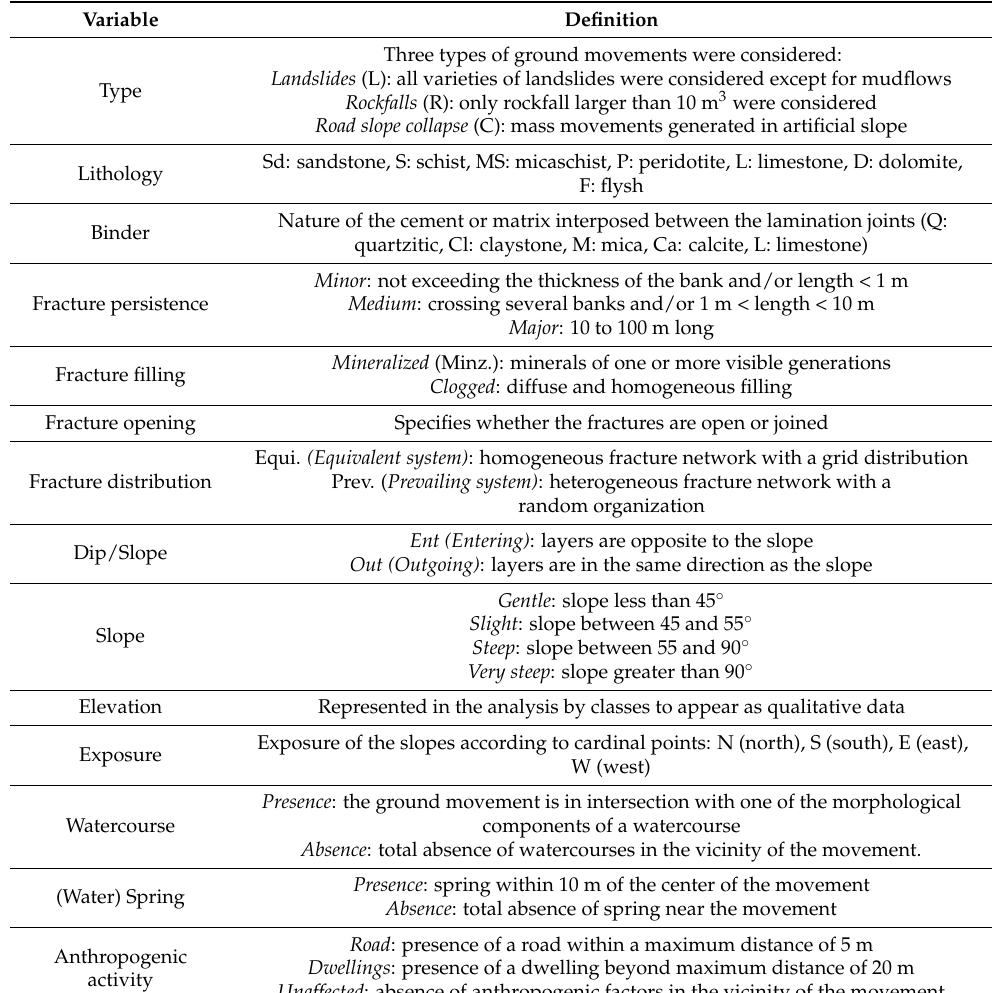
Table 1. Definition of the MCA variables, also used in Appendix A (Table